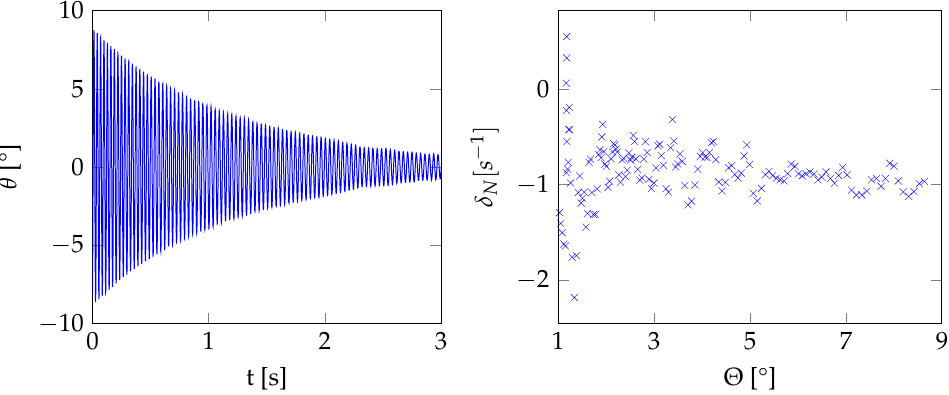
Figure 4. Pitch angle over time ( left ) and δ N measurements over oscillation amplitude Θ ( right ) for a test with the ANSR model at Mach